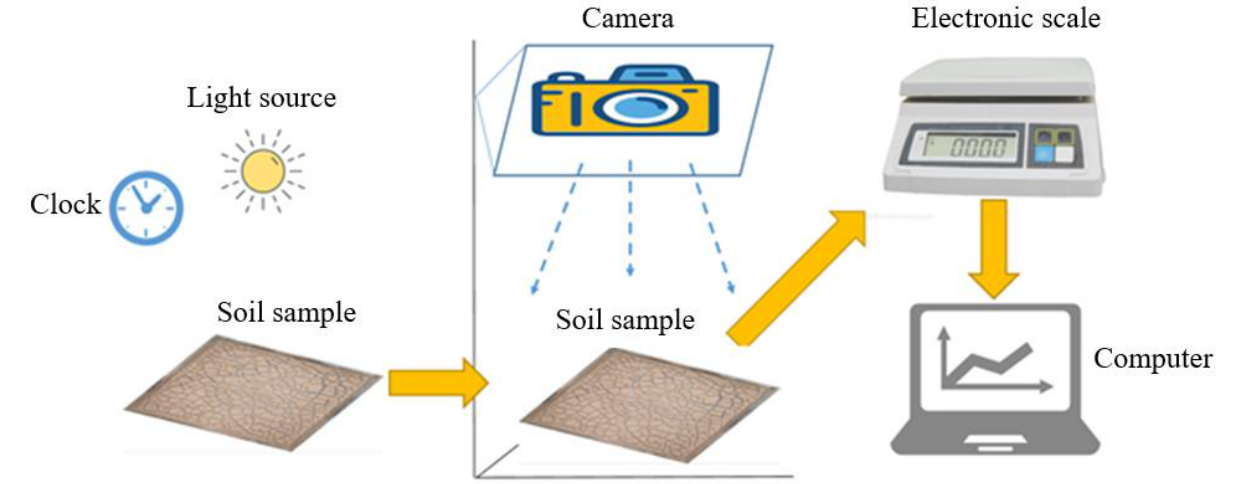
Figure 3. Schematic diagram of weighing and photographing device.